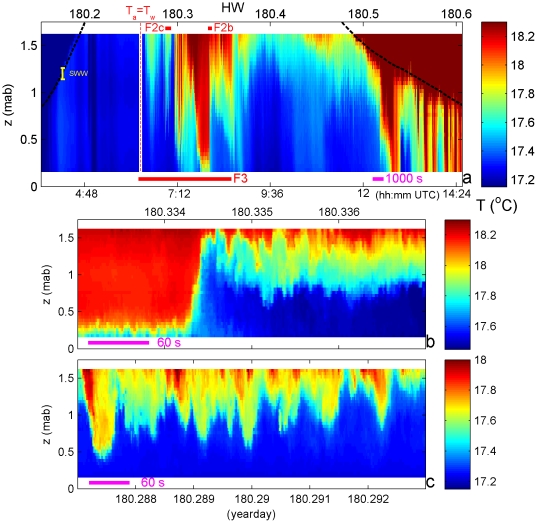
Almost one tidal period overview of detailed temperature (T) variations near Texel beach in early summer.The vertical scale is 1.75 m with reference to the bottom. For display purposes, the colour-scale does not completely cover the observed water temperature range of [17.05, 18.97]°C. a. The small red bars indicate zooms in b., c. and the large one indicates the period of Figure 3. The vertical red-in-white line indicates when Ta = Tw using upper thermistor in water and atmospheric data from Den Helder-airport. The black dashed curves indicate the predicted tidal sea-level height variation (sensors in air above it) and the yellow bar on the left spread of surface wind wave height, estimated from the water surface passing T-sensors. Time (UTC) is 0.33 hours before local SolarTime. b. Zoom of a front and trailing 80 s period IW and shorter period IW-turbulence motions. c. Zoom of high-frequency (60 s period) internal waves and shorter scale overturning.